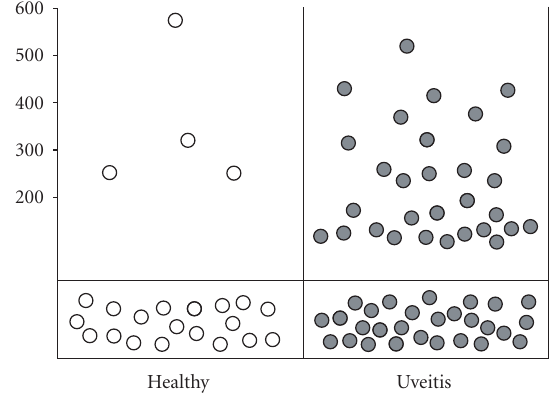
Figure 3: Frequency and intensity of human IgG autoantibodies to CRALBP. White circles represent healthy individuals, grey circles human uveitis patients. Western blot signal intensities were quan- tified with Image Quant TL software, grayscale pixel intensity of bands is given as arbitrary units (Y-axis). Negative reactions are dis- patched below cuto ff line. CRALBP autoantibodies occurred signif- icantly more frequently in uveitis patients as in control group (com- pared by chi-square test, significance level < 0 .